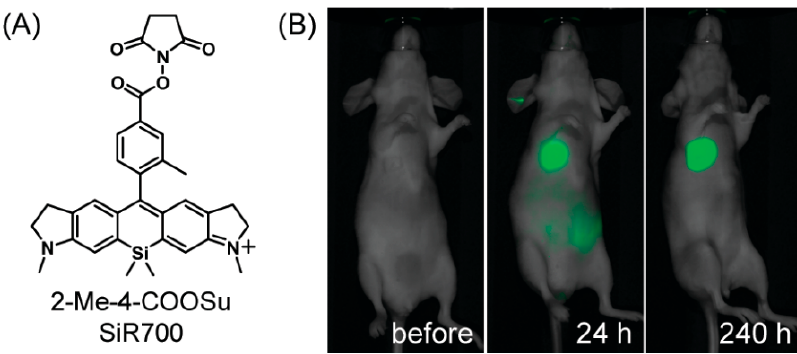
Figure 14. ( A ) The structure of 2-Me-4-COOSu SiR700. ( B ) In vivo tumor imaging with SiR700-labeled anti-tenascin-C antibody [94]. Copyright 2012, American Chemical Society.